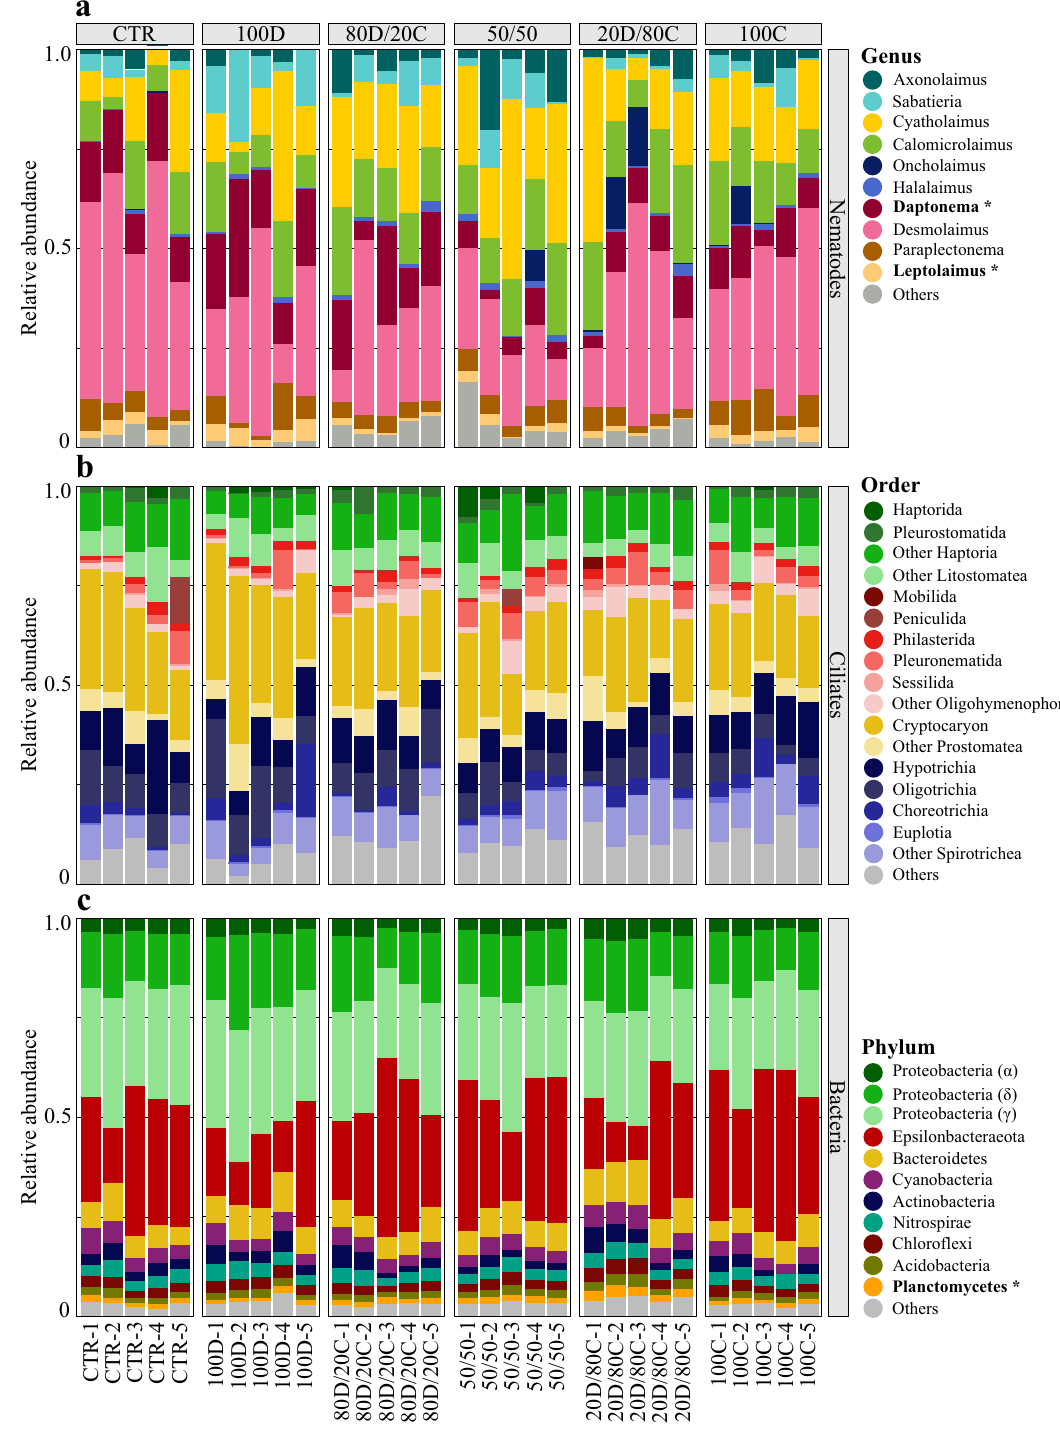
Figure 1. Taxonomic composition of ( a ) nematodes (18S rRNA, Genus level), ( b ) ciliates (18S rRNA, Order level) and ( c ) bacterial (16S rRNA, Phylum level) communities, displayed as ASVs relative abundances. Taxonomic groups showing significant differences in relative abundance across treatments after multiple testing correction are indicated in bold and with an asterisk (*). See Fig. 6 for labels on the